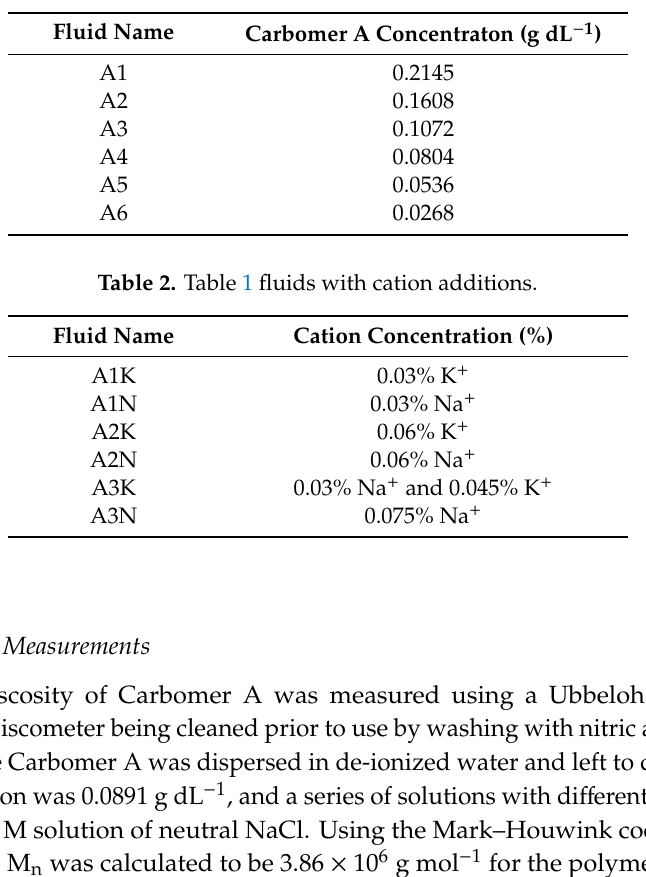
Table 1. Carbomer A additions to 50:50 (wt / wt) mono-propylene glycol / water mixtures.